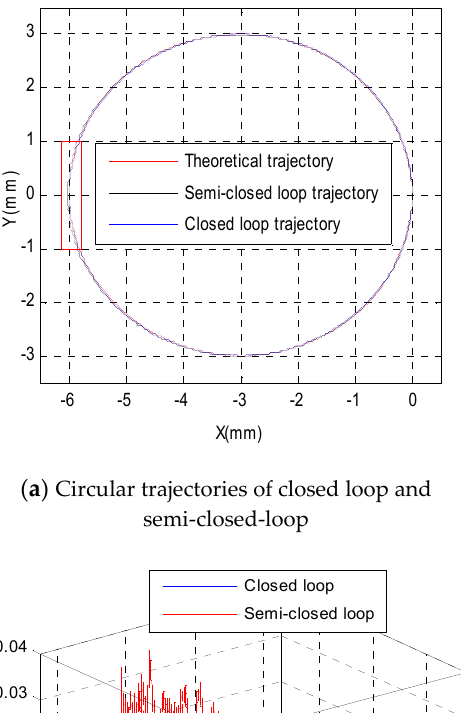
( a ) ( b ) Figure 13. Circular trajectory tracking with a PI controller, 0.8, 0 p i K K =